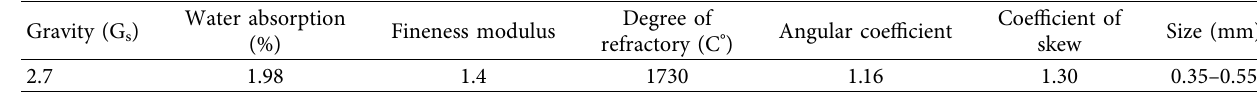
Table 4: Physical characteristics of silica sand.